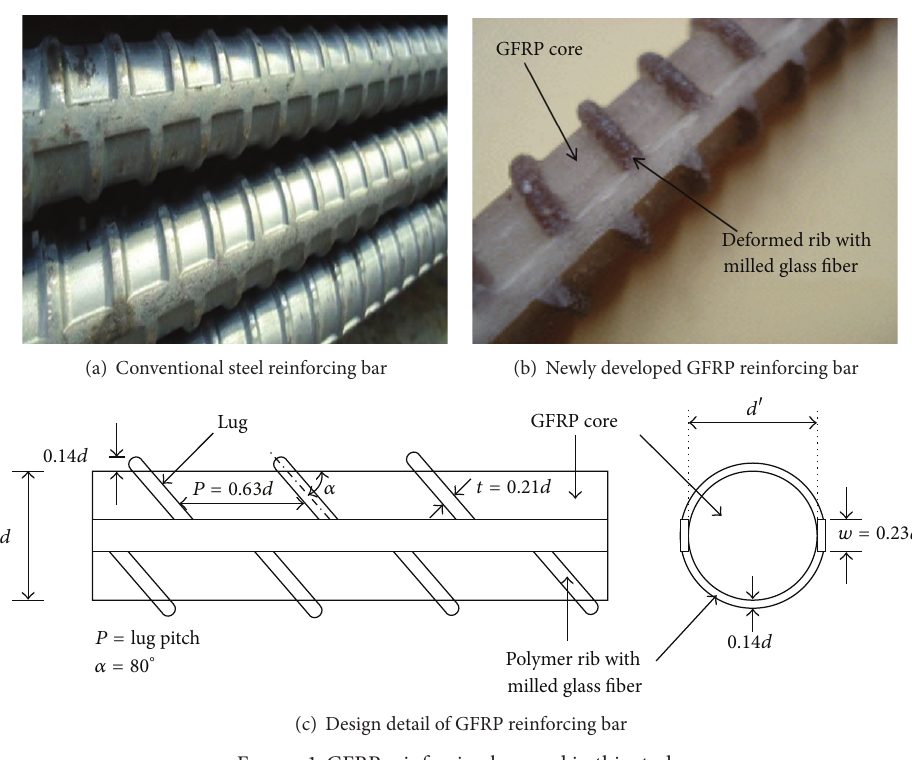
Figure 1: GFRP reinforcing bar used in this